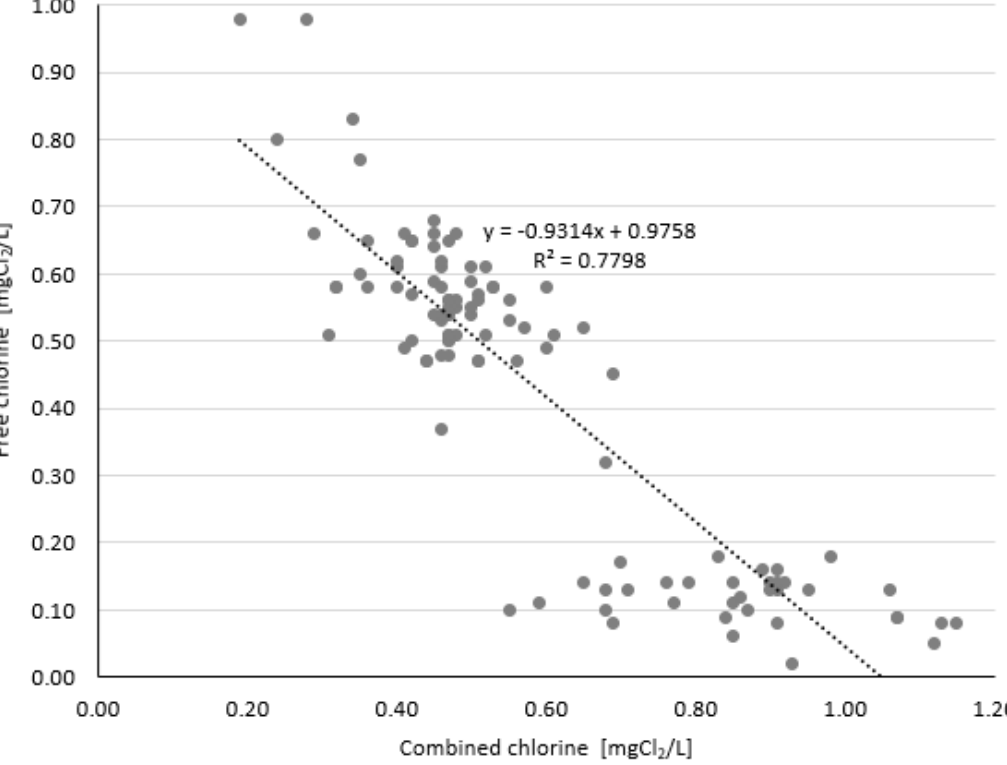
Figure 4. The distribution of combined chlorine in the selected points of the basins.